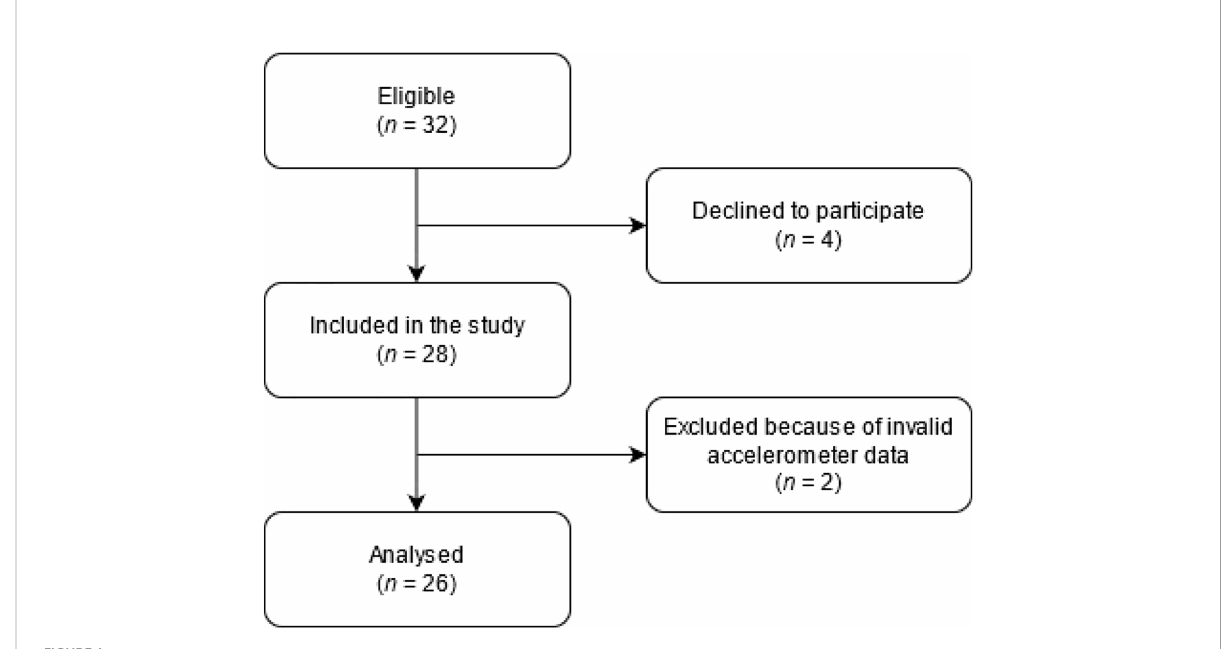
FIGURE 1 Flowchart of the